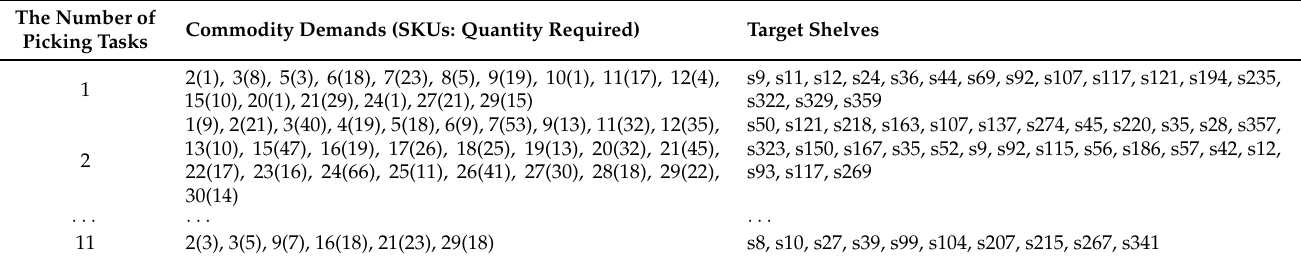
Table 5. Picking order and target shelf solution under the batching strategy with hybrid time window